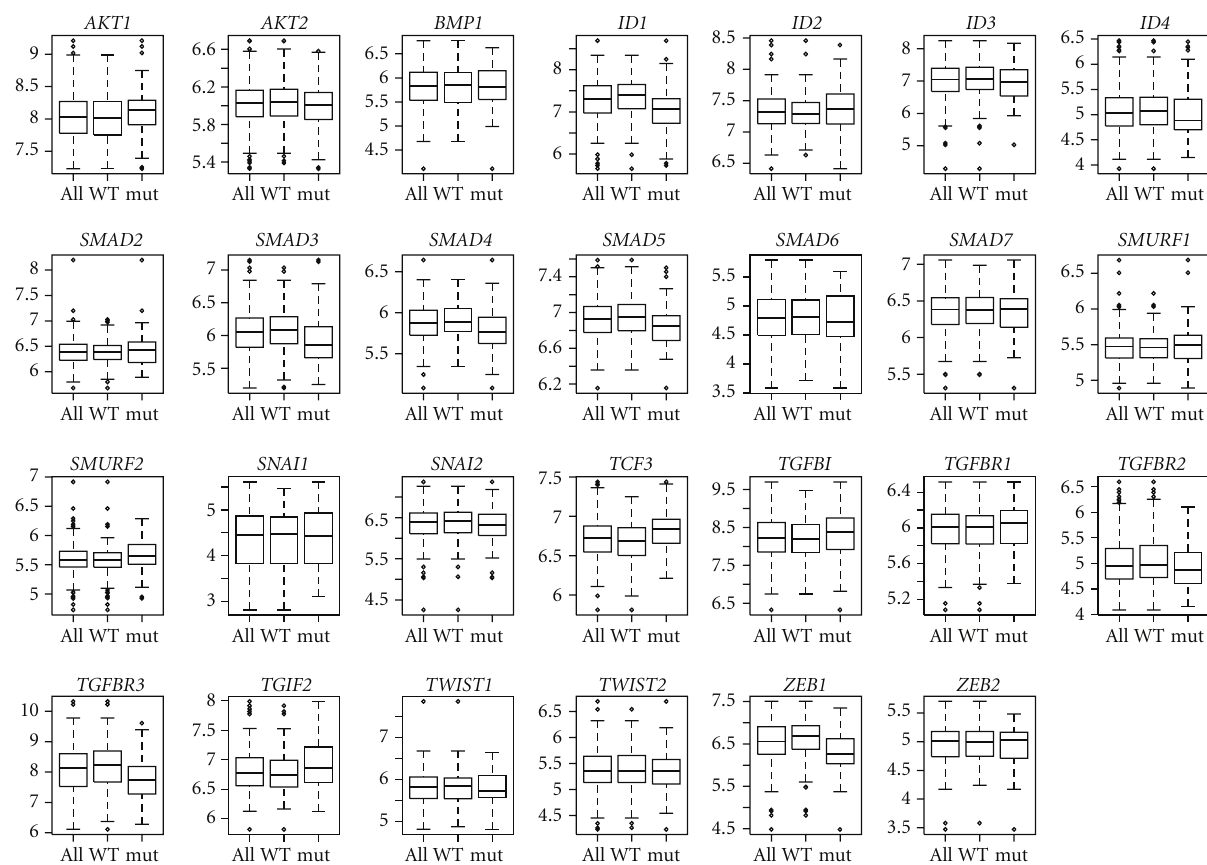
Figure 2: Boxplots of the genes associated with EMT in wild-type (WT) or mutant (mut) TP53 tumors with respect to overall case series